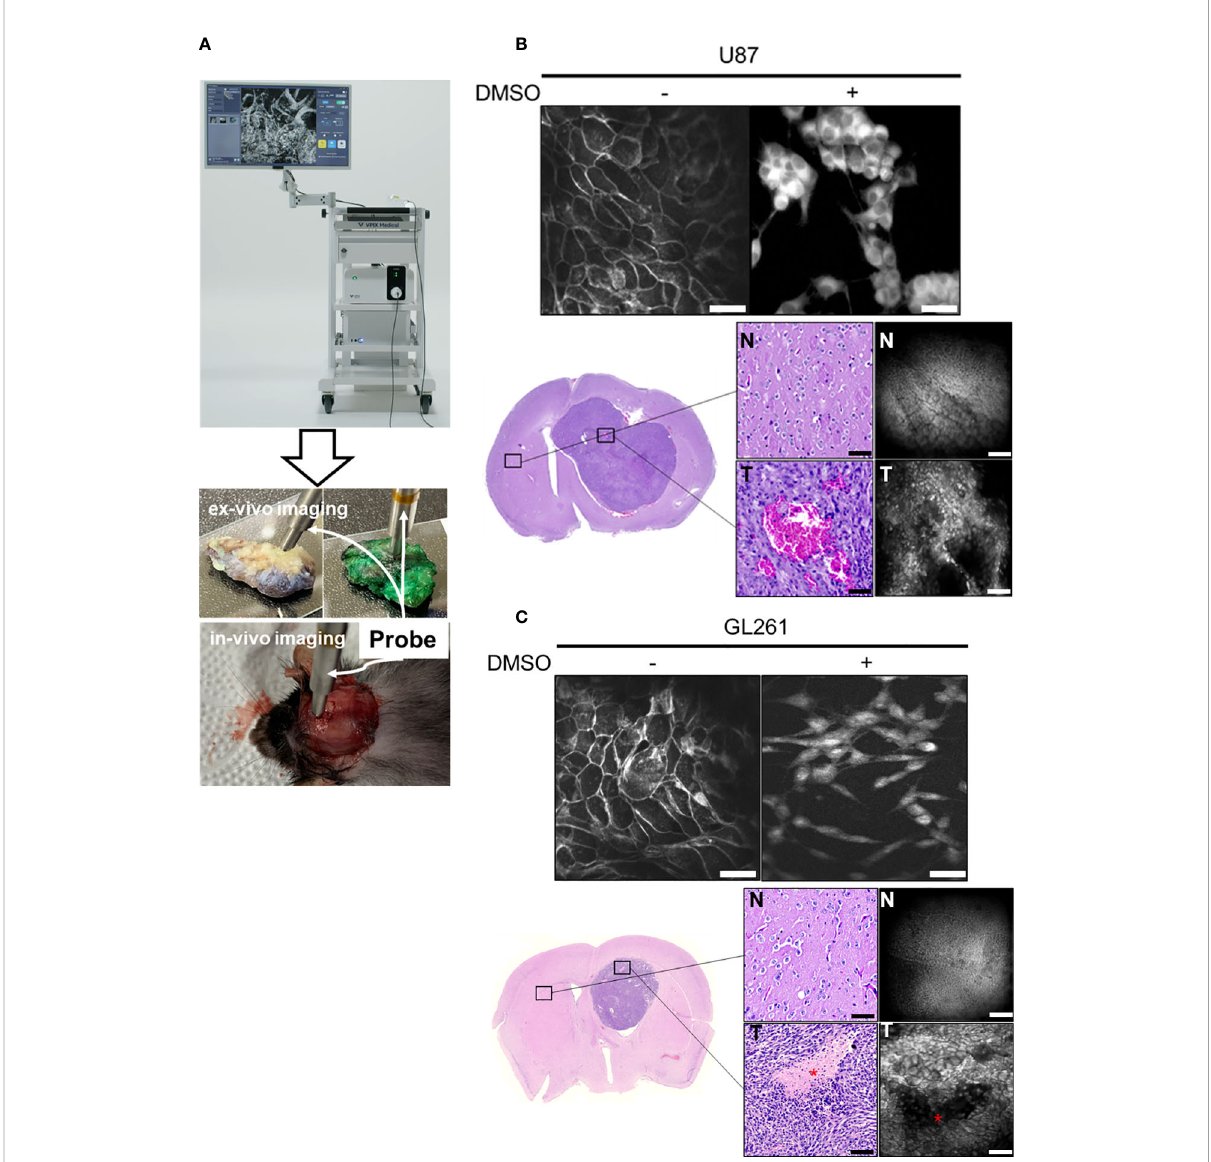
FIGURE 2 CLE systems and photomicrographs of various glioma models (A) The Lissajous scanning CLE system consists of an imaging screen, miniaturized probe, and excitation light source. The probe can detect the CLE images of brain tumor tissue both ex vivo and in vivo . In the current study, only ex-vivo imaging was obtained and compared. (B, C) Image acquisition of U87 human and GL261 mouse glioma cells was conducted using CLE following incubation with 5 mg/mL indocyanine green (ICG) (upper panel). Cell morphology was examined in the presence/absence of dimethyl sulfoxide (DMSO). In an orthotopic xenograft model, ICG-induced fl uorescent imaging and the corresponding H&E stain were obtained at the tumor core and normal brain (lower panel). CLE image shows dense fl uorescent neoplastic cells following ICG incubation ex vivo . N: normal brain, T: tumor, Asterix: necrosis. Scale bar: 50 µm. H&E = hematoxylin and